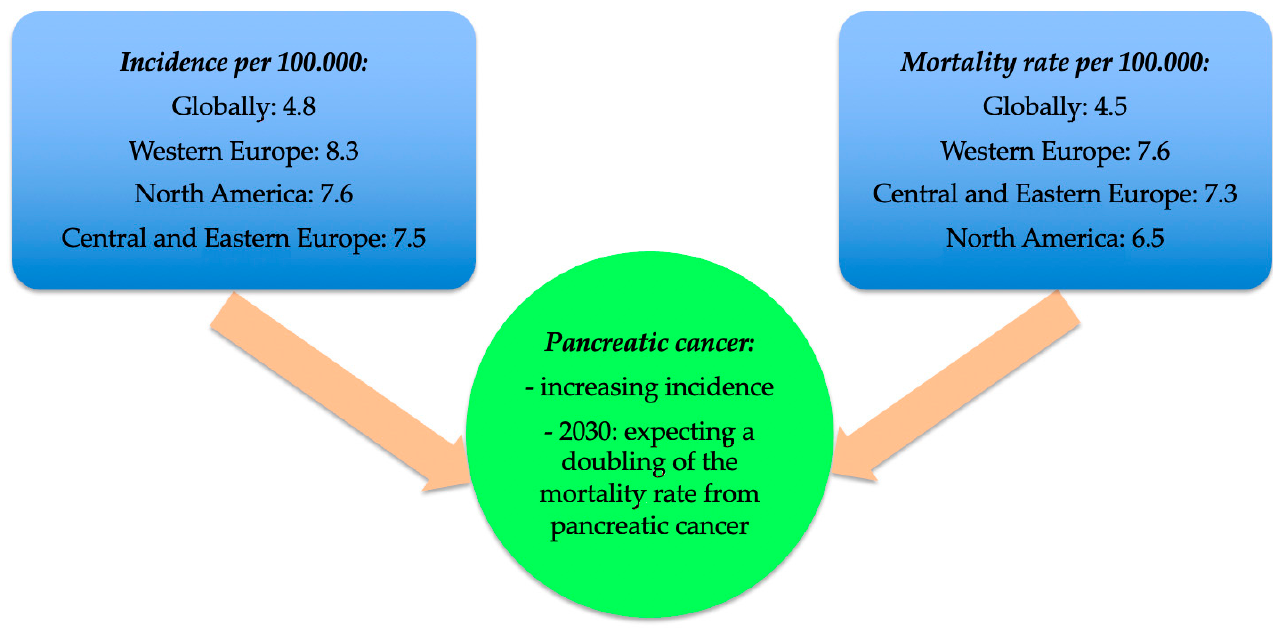
Figure 1. Incidence and mortality rates of pancreatic cancer [5].